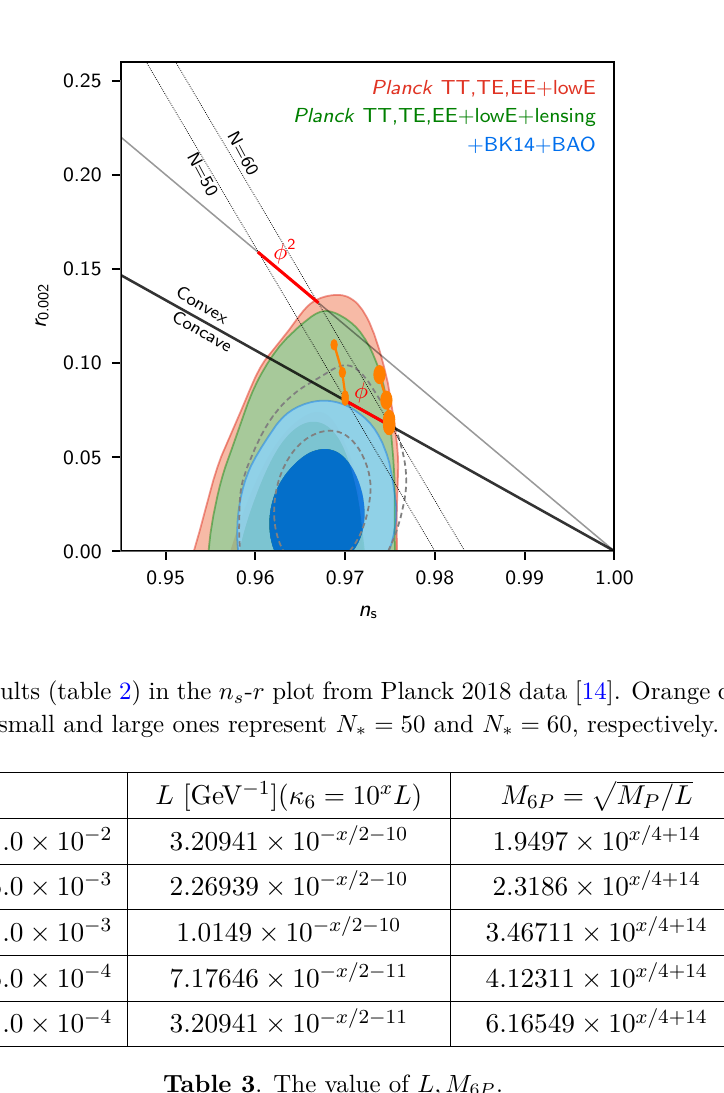
Table 3 . The value of L, M 6 P